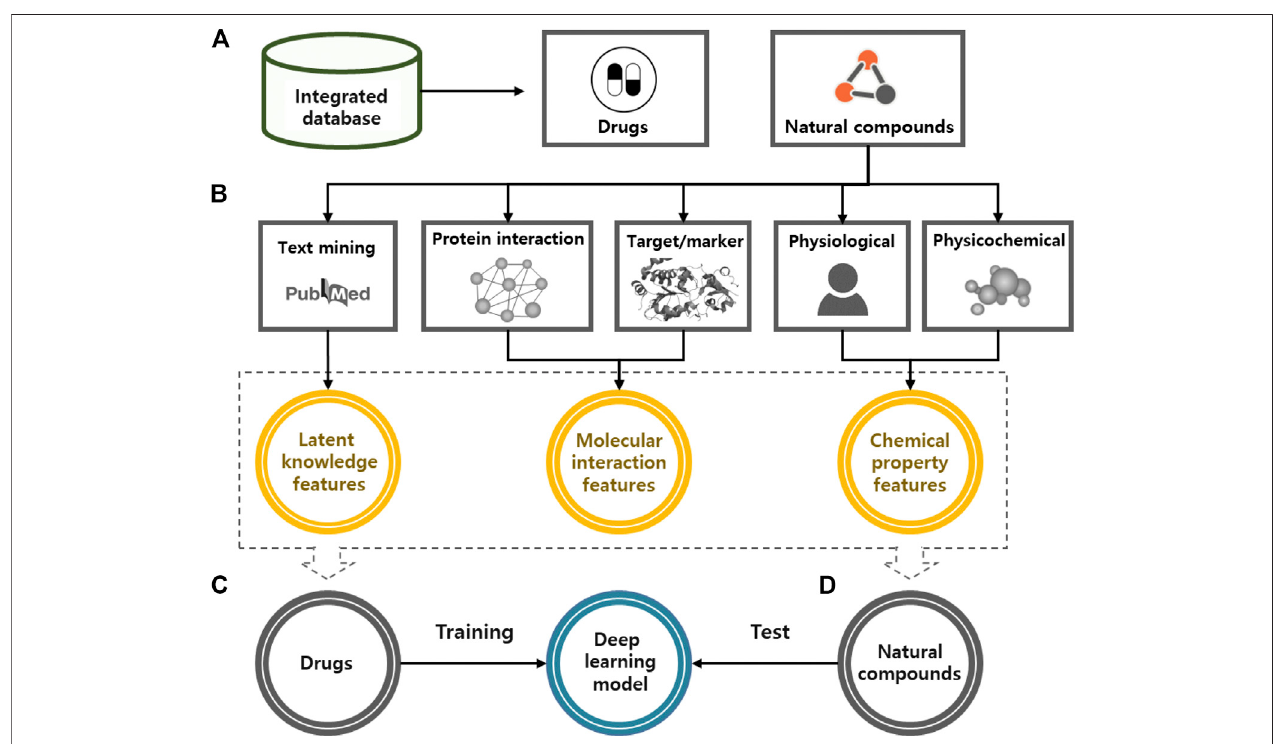
FIGURE 2 | A systematic procedure of deep learning model for the identi fi cation of medicinal use of natural compounds. (A) We constructed an integrated databasetomergevarioustypesofdrugandnaturalcompoundinformation. (B) Forallnaturalcompoundsanddrugs,inputfeaturesweregeneratedbasedonthelatent knowledge, molecular interaction and chemical property information. (C) We trained a deep learning model by using the extracted features and known ef fi cacy of approved drugs. (D) Potential medicinal use of natural compounds was predicted by applying extracted features of natural compounds to the trained model.